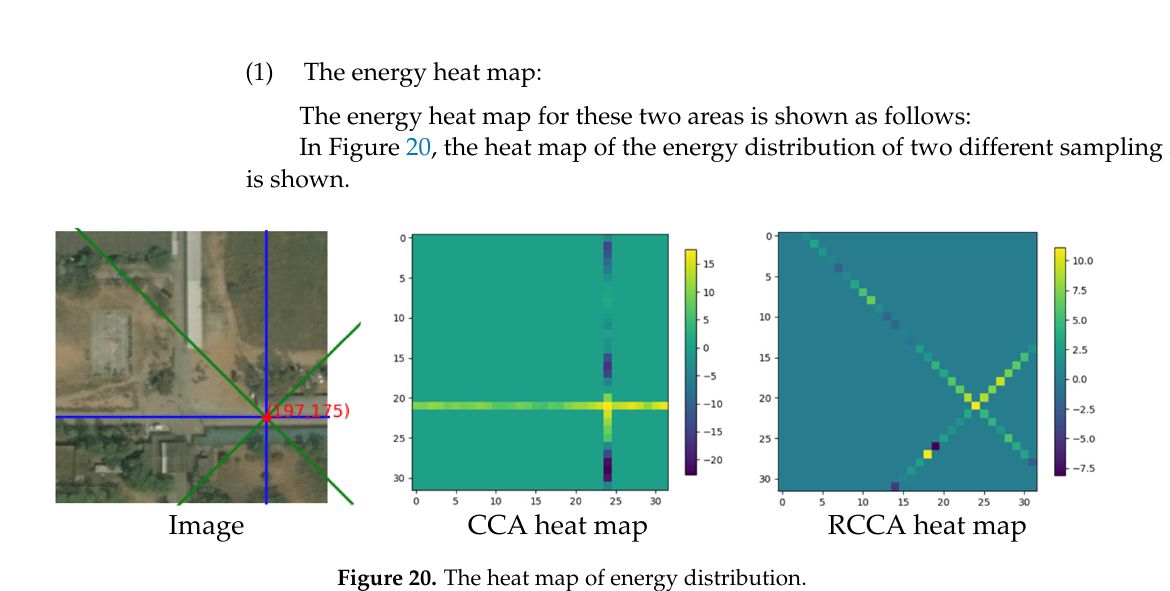
Figure 19. The image and its corresponding ground truth.